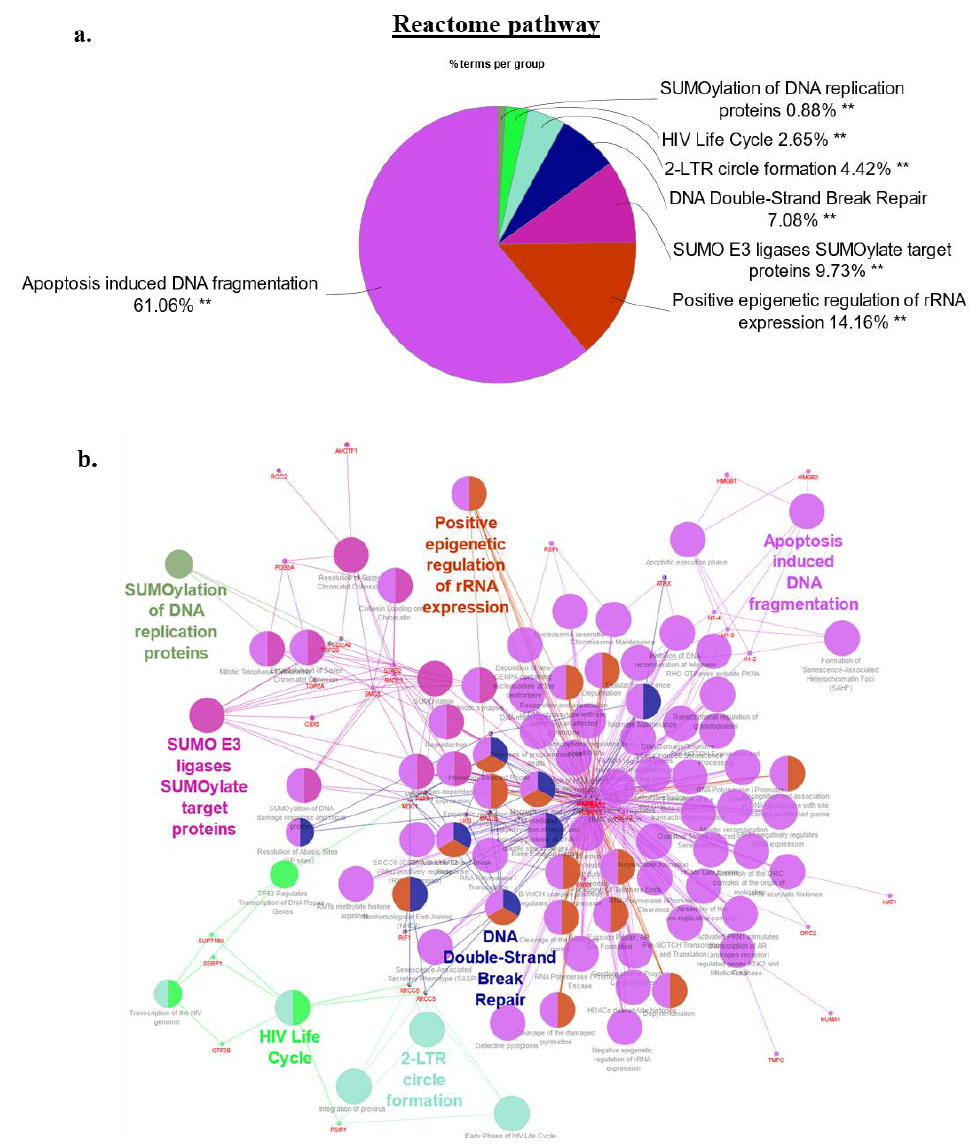
Figure 6. ( a , b )REACTOME pathway analysis of the 62 top candidate proteins identified in the HMGA2-BioID2 and -miniTurbo biotin proximity assay. ( a ) There were 7 REACTOME pathway groups identified, with the two largest groups 5 and 6 mainly encompassing nucleosomal and chromatin-associated processes, and contributing approx. 75% of all pathways due to the over-representation of nucleosomal histone interaction partners of HMGA2 in both pathways. Pathways with more diversified contributions by HMGA2 interaction partners included post-translational protein SUMOylation related REACTOME pathways, accounting for 10%, and double stranded DNA repair (7%). A detailed list of contributing HMGA2 interaction partners to the Reactome pathways is presented in Suppl. Figure 1a – d. ( b ) Network map with identical color coding of key Reactome pathways. Analysis was performed with Cytoscape version 3.8 and ClueGo v2.5.9. Adjusted p -values considered statistically significant as denoted by ** p < 0.001.